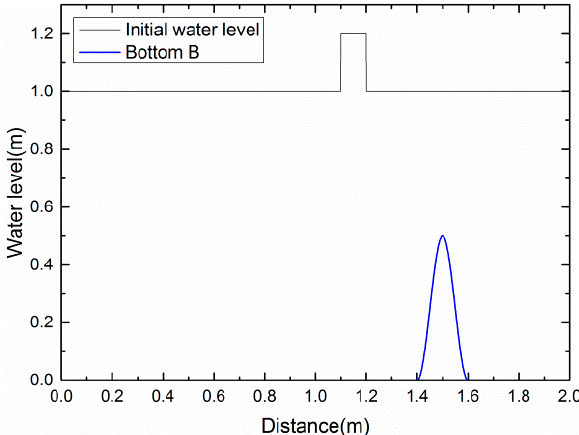
Figure 15. Small perturbation test. The initial conditions with ε = 0.2 (big pulse).